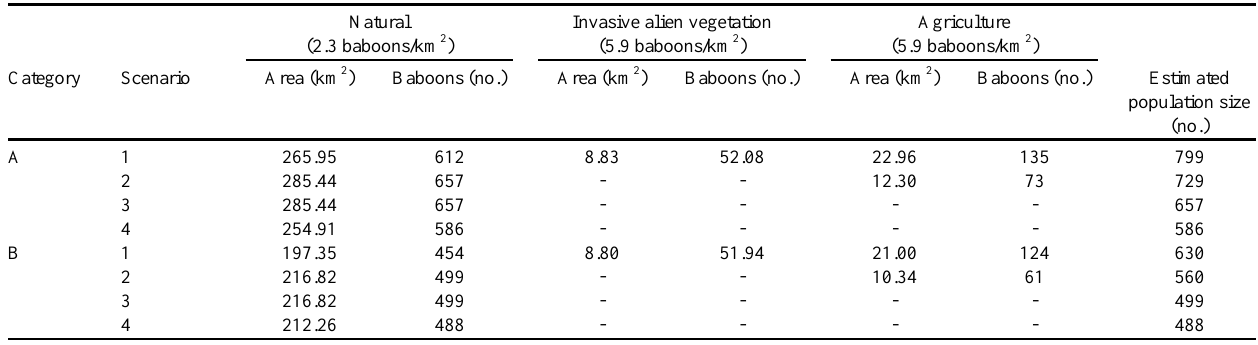
Table 1 . Estimated size of the Cape Peninsula baboon population, by land-availability scenario and habitat composition. Natural Invasive alien vegetation